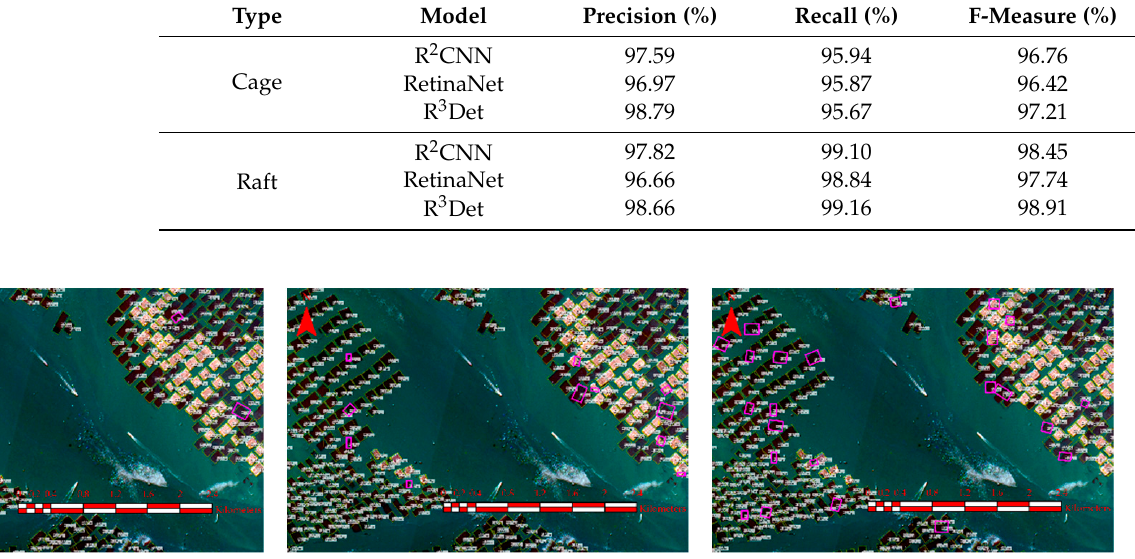
Figure 11. Comparisons of the extraction results of R 3 Det ( left ), R 2 CNN ( middle ), and RetinaNet ( right ). The pink rectanglew represent bounding boxes that did not fit the aquaculture zones well.